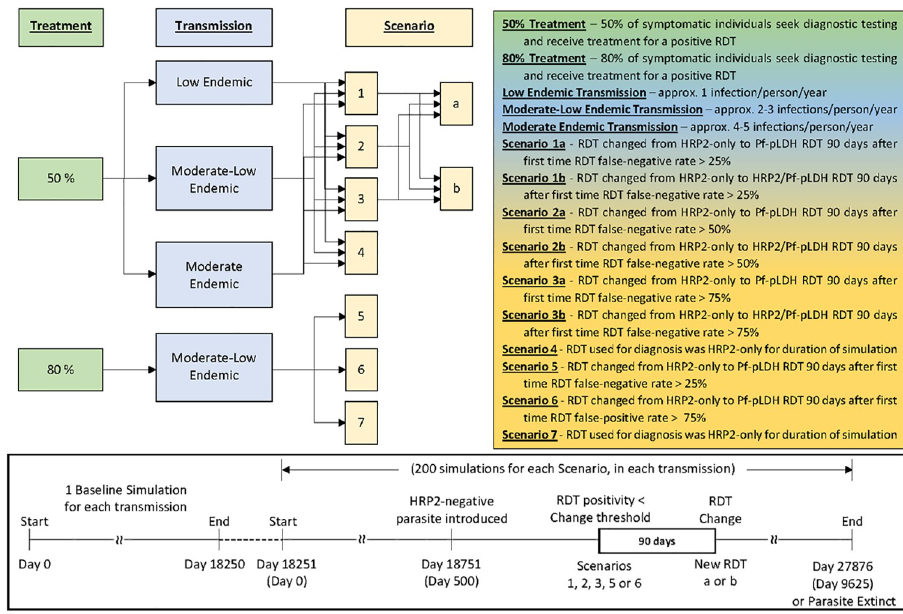
Fig 1. Flowchart outlining simulation